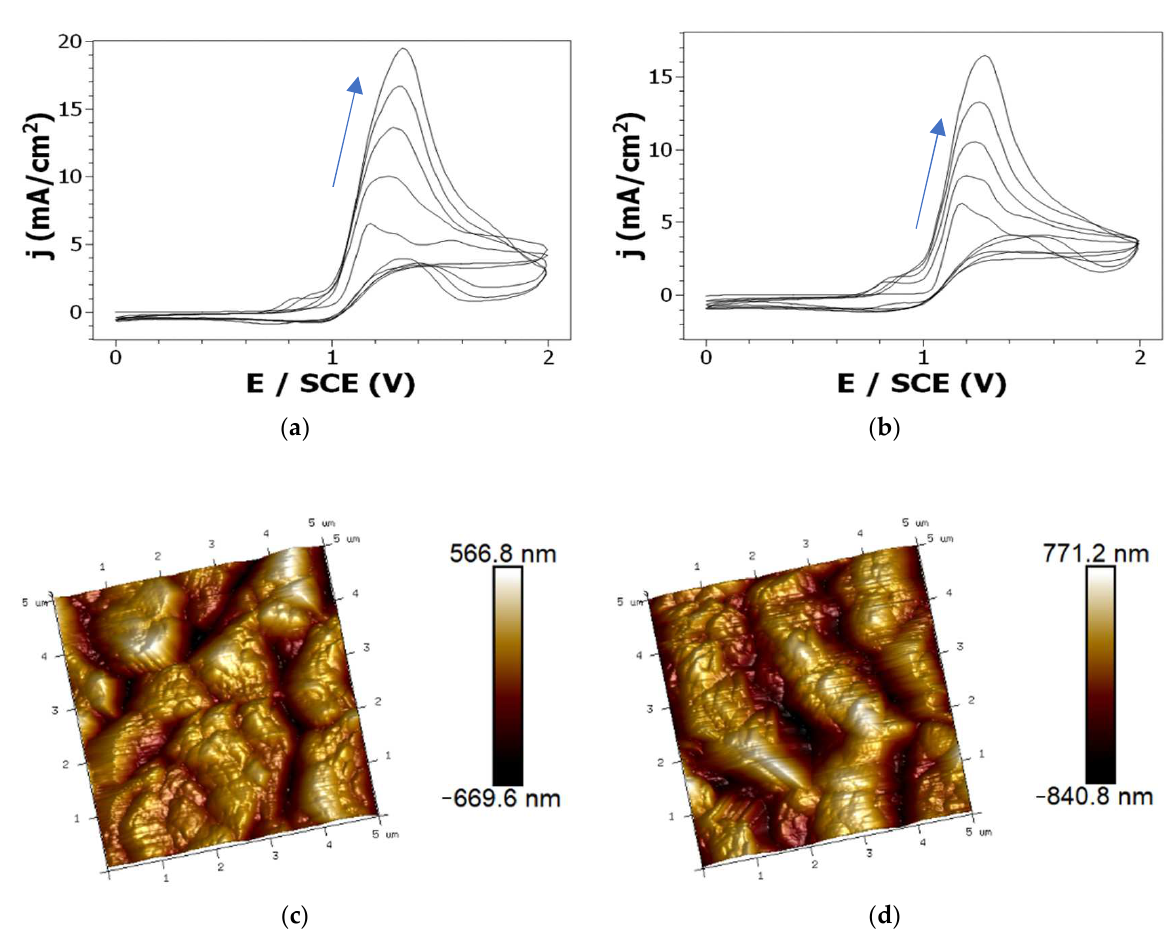
Figure 5. Cyclic voltammograms obtained by oxidation of: 95:5 Cz:CzA ( a ) or 90:10 Cz:CzA ( b ) in an acetonitrile + 0.1 M LiClO 4 solution (WE: Pt. Scan rate: 50 mV/s) and 3D morphology AFM pictures of the polymer films resulting from the electro-oxidation of 95:5 Cz:CzA ( c ) and 90:10 Cz:CzA ( d ) solutions.